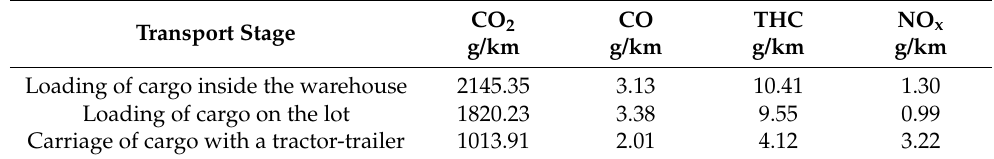
Table 3. Road emission of the transport